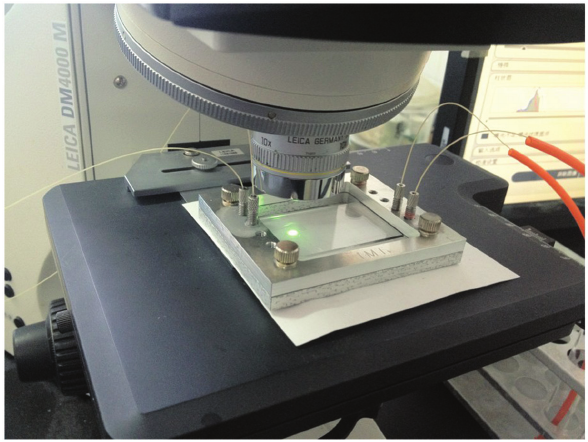
Figure 2 Microreactor channel conditions monitored by optical